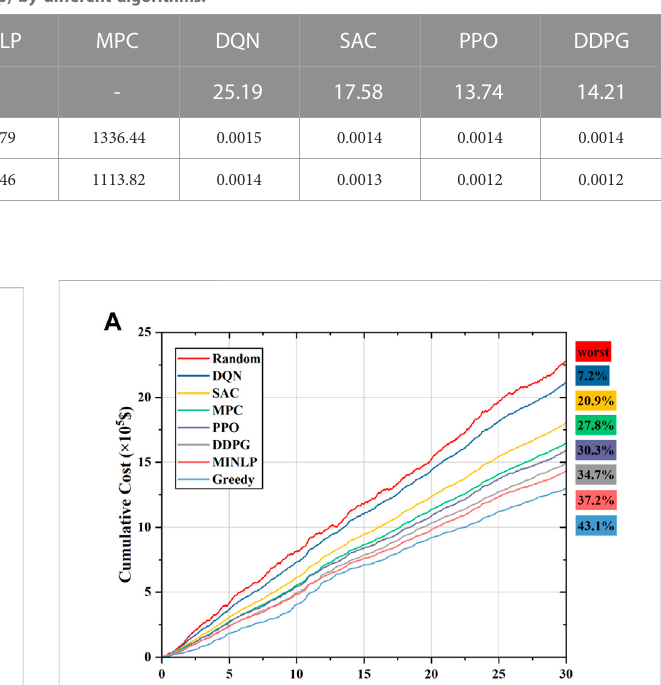
TABLE 4 Time consumption on training and online computation (one step) by different algorithms.